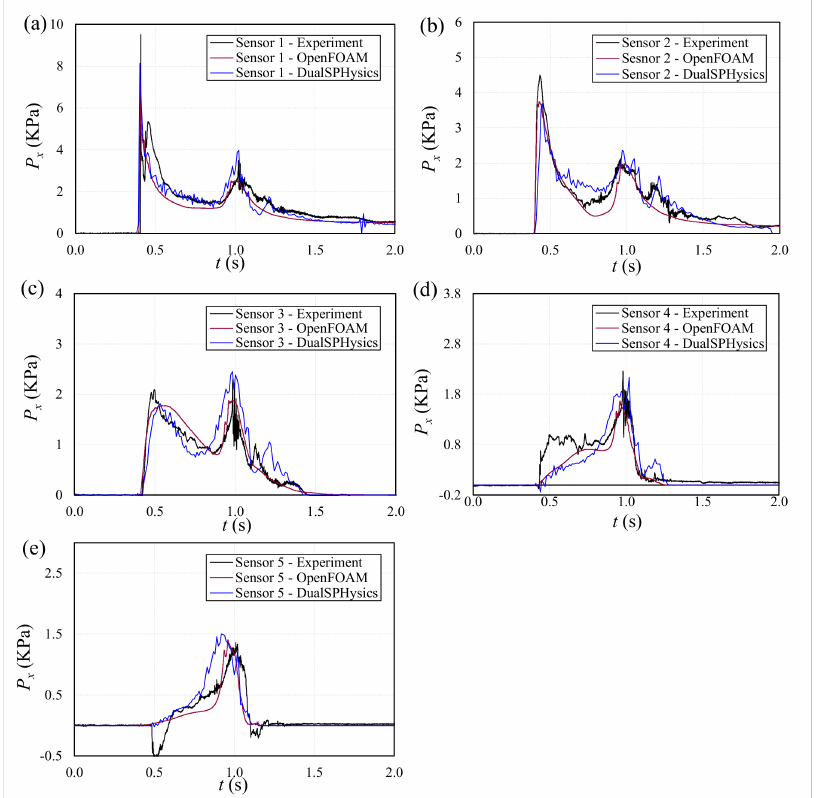
Figure 6. Tim-history of the dynamic pressure comparison of experimental data and numerical results obtained using the OpenFOAM and DualSPHysics models for transducer 1 to